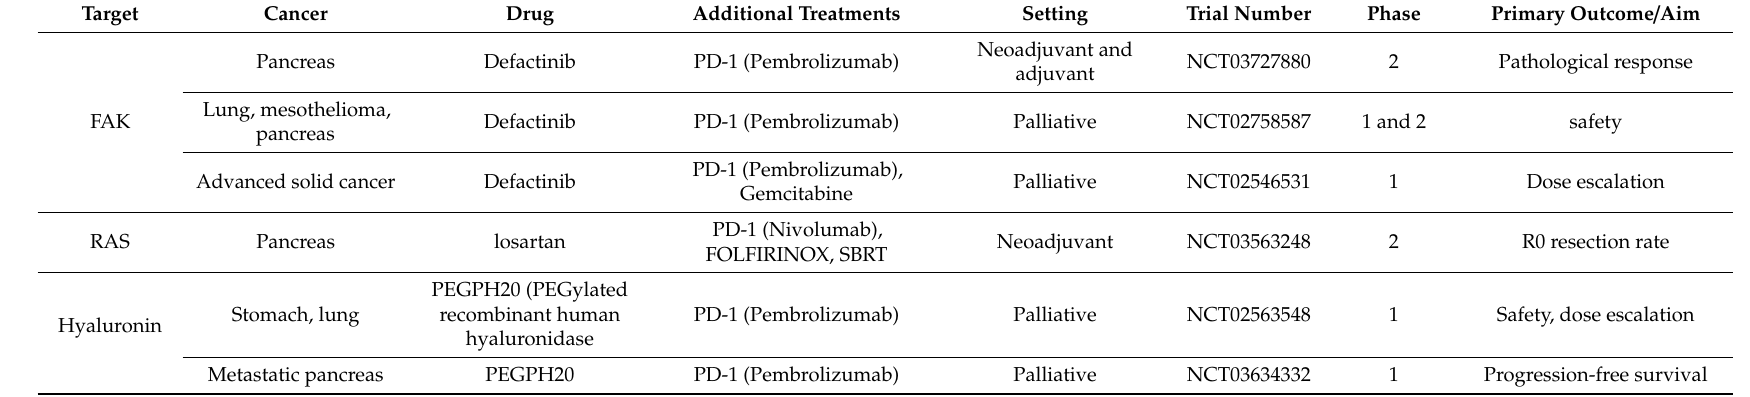
Table 1. Examples of clinical trials combining agents targeting the tumour ECM with immune checkpoint inhibition. FAK focal adhesion kinase, RAS renin-angiotensin